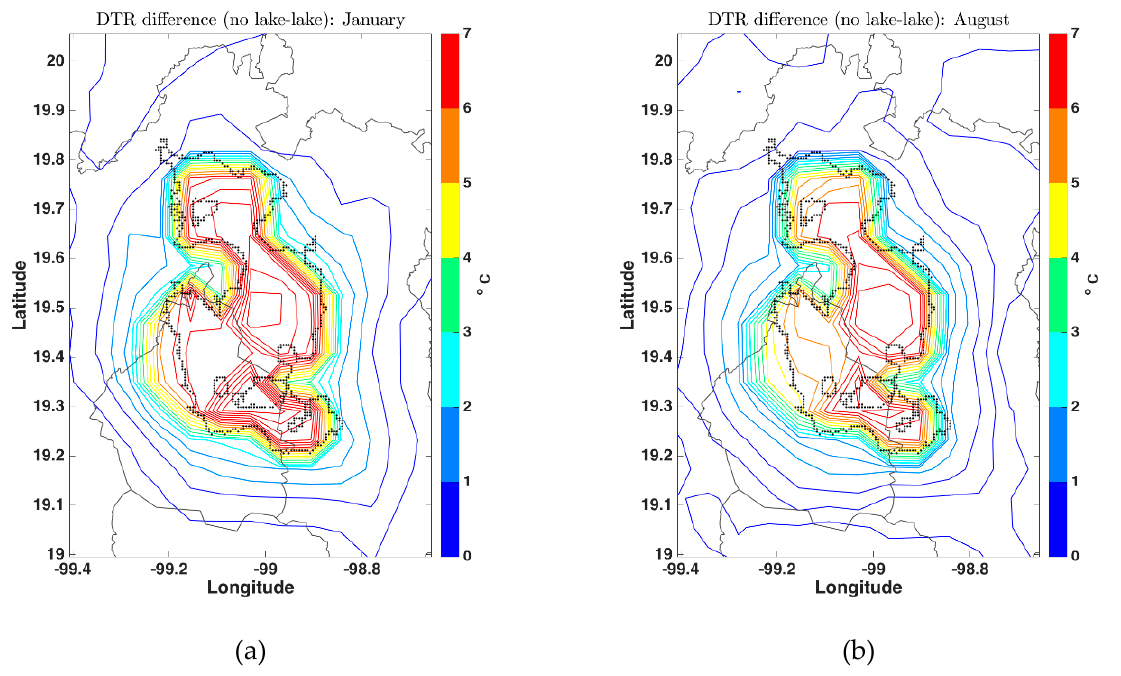
Figure 8. Mean diurnal temperature range (DTR) difference between the NL/WRFc and L/WRFc simulations in January ( a ) and August ( b ).